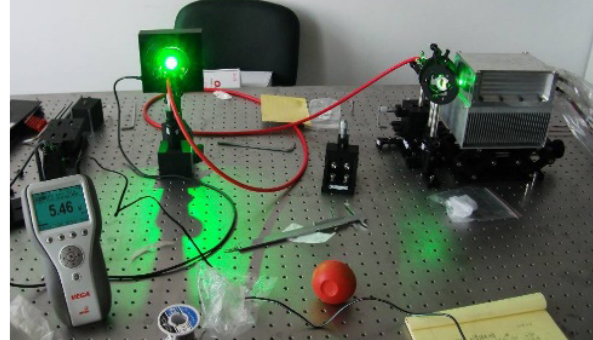
Fig. 8. Coupling the 532-nm laser with the optical ¯ber using the beam combiner and lens.